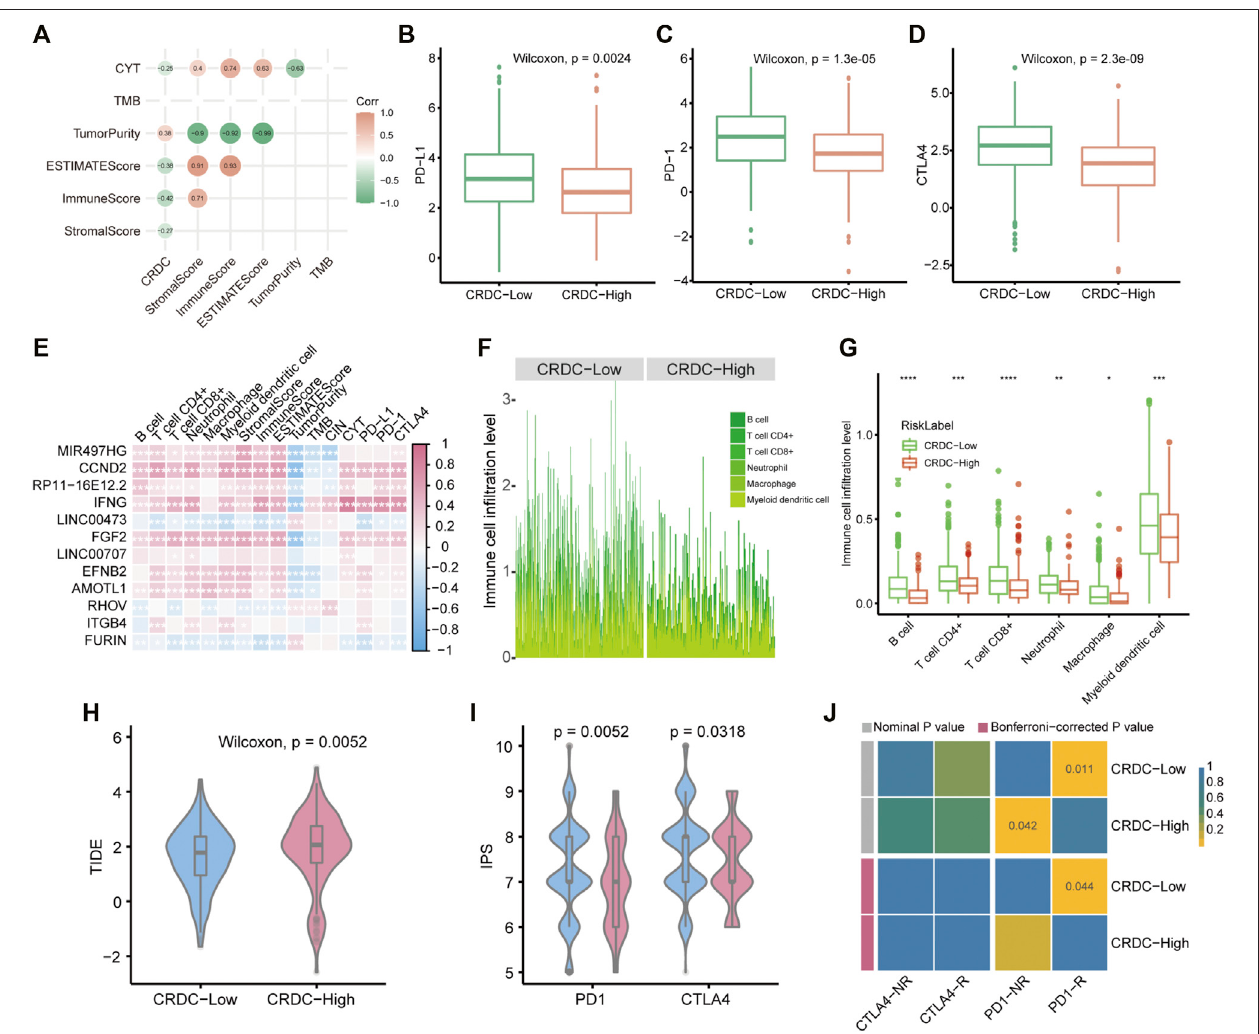
FIGURE 7 | CRDC-related immune in fi ltration characteristics. (A) Spearman correlation analysis plot of the correlativity of the CRDC score, StromalScore, ImmuneScore, ESTIMATEScore, TumorPurity, TMB, and CYT. Boxplots described the expression difference of (B) PD-L1, (C) PD-1, and (D) CTLA4 between CRDC- High and CRDC-Low samples. (E) Spearman correlation heatmap of CRDC genes and immune microenvironment cell in fi ltration, StromalScore, ImmuneScore, ESTIMATEScore, TumorPurity, TMB, CIN, CYT, PD-L1, PD-1, and CTLA4. (F,G) Immune microenvironment cell in fi ltration level in CRDC-High and CRDC-Low samples. The violin plots displayed the TIDE (H) and IPS (I) scores between CRDC-High and -Low groups. (J) Heatmap of comparison and identi fi cation of common subtypes between groups divided by CRDC risk and response for ICB therapy. NR and R represented not respond and respond to immunotherapy, respectively.